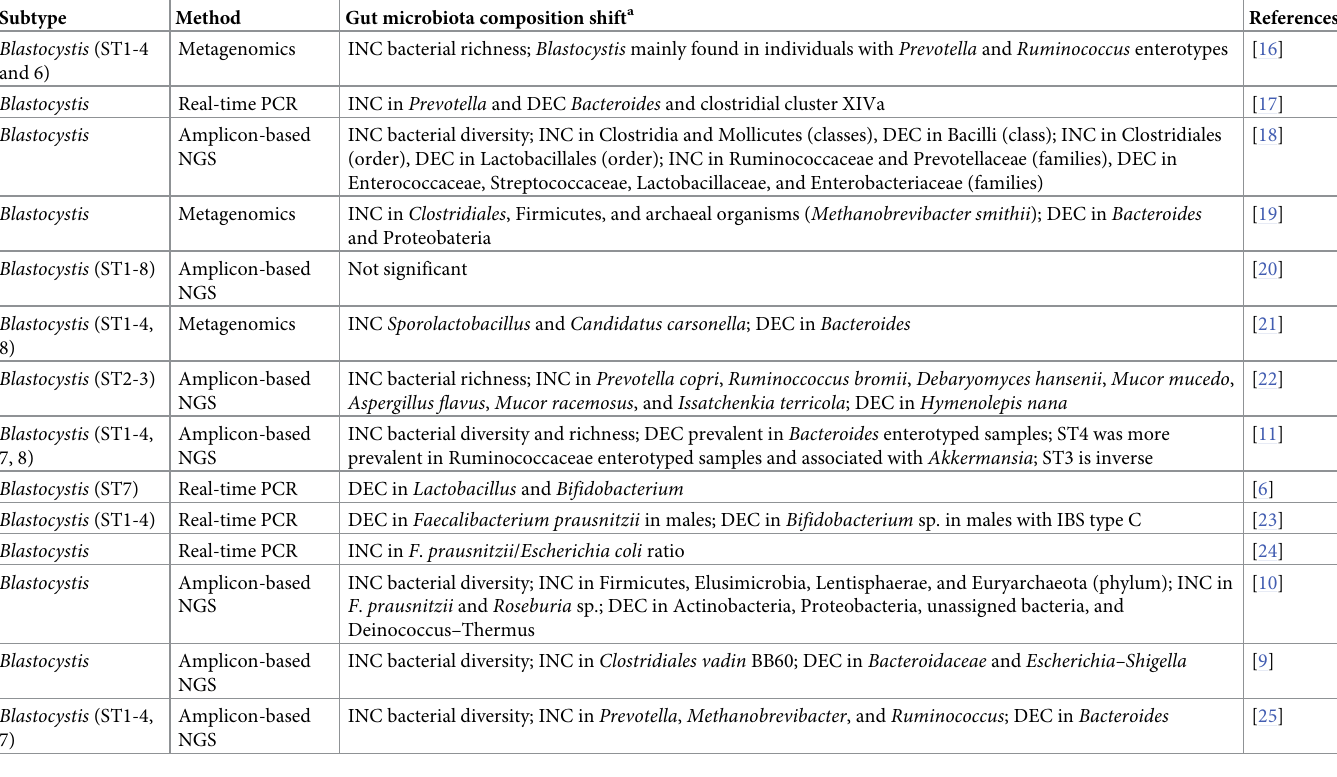
Table 1. Studies on associations between Blastocystis and gut microbiota